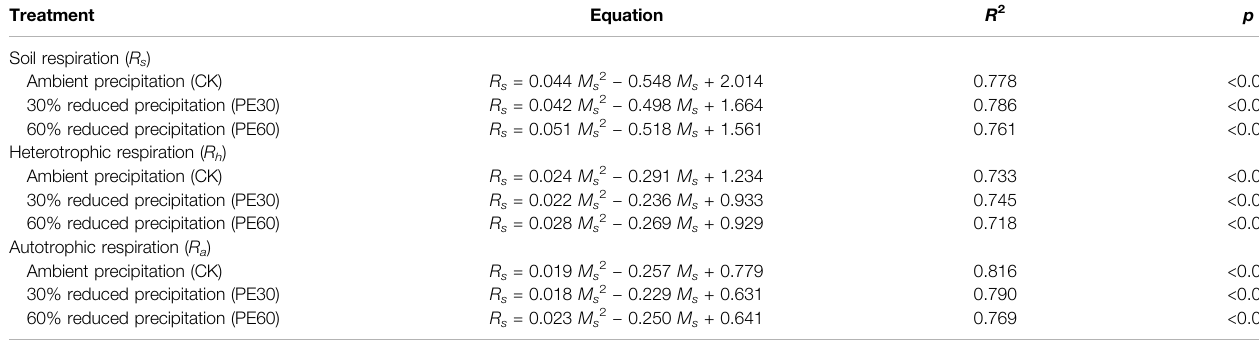
TABLE 2 | Impacts of soil moisture ( M s , %) on the variation of different soil respiration components ( R , μ mol m − 2 s − 1 ). R 2 and p values are reported. Treatment